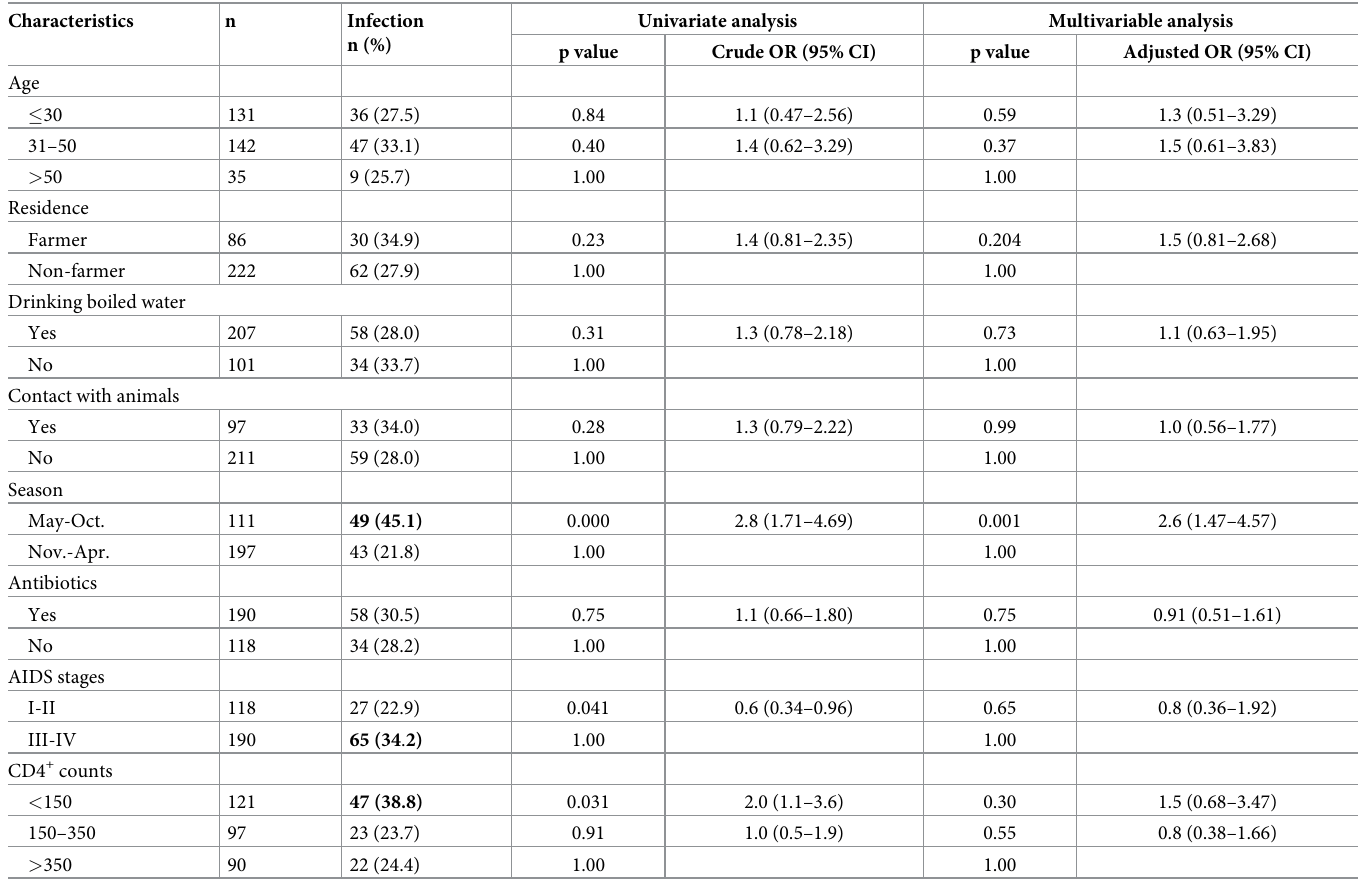
Bold = the values statistically significant higher than that in the same group were shown in bold. OR = odds